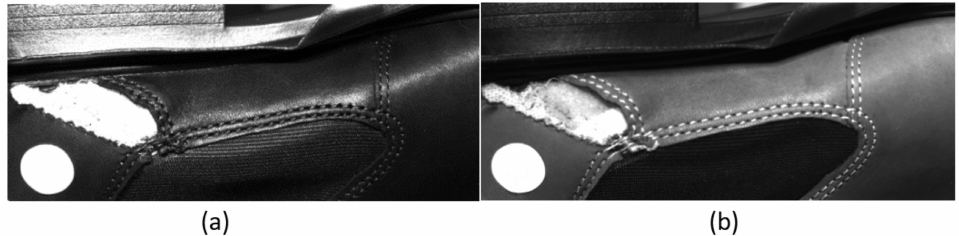
Figure 6. Comparison of 200 mm red light ( a ) and circular 100 mm IR light ( b ).